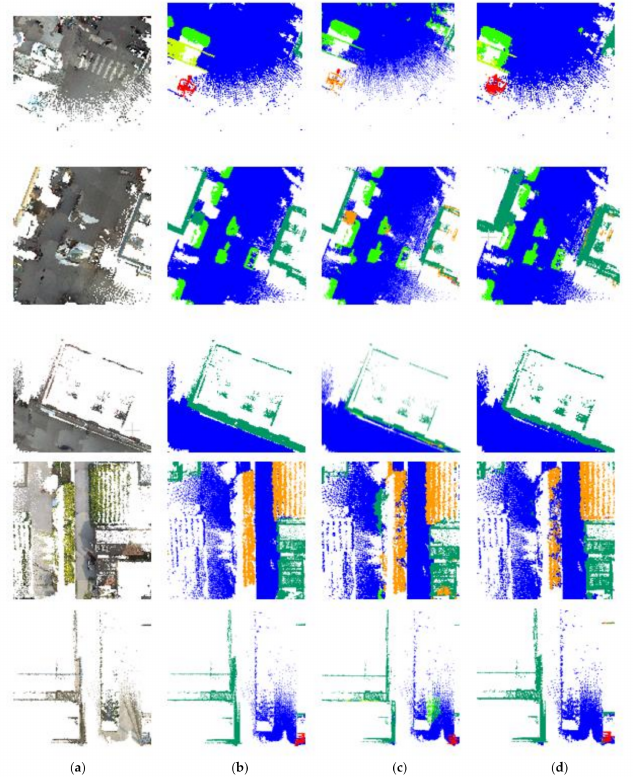
Figure 6. The visual examples in CSPC Dataset. ( a – d ) represent point cloud with RGB, ground truth, the prediction results of RandLA-Net, and